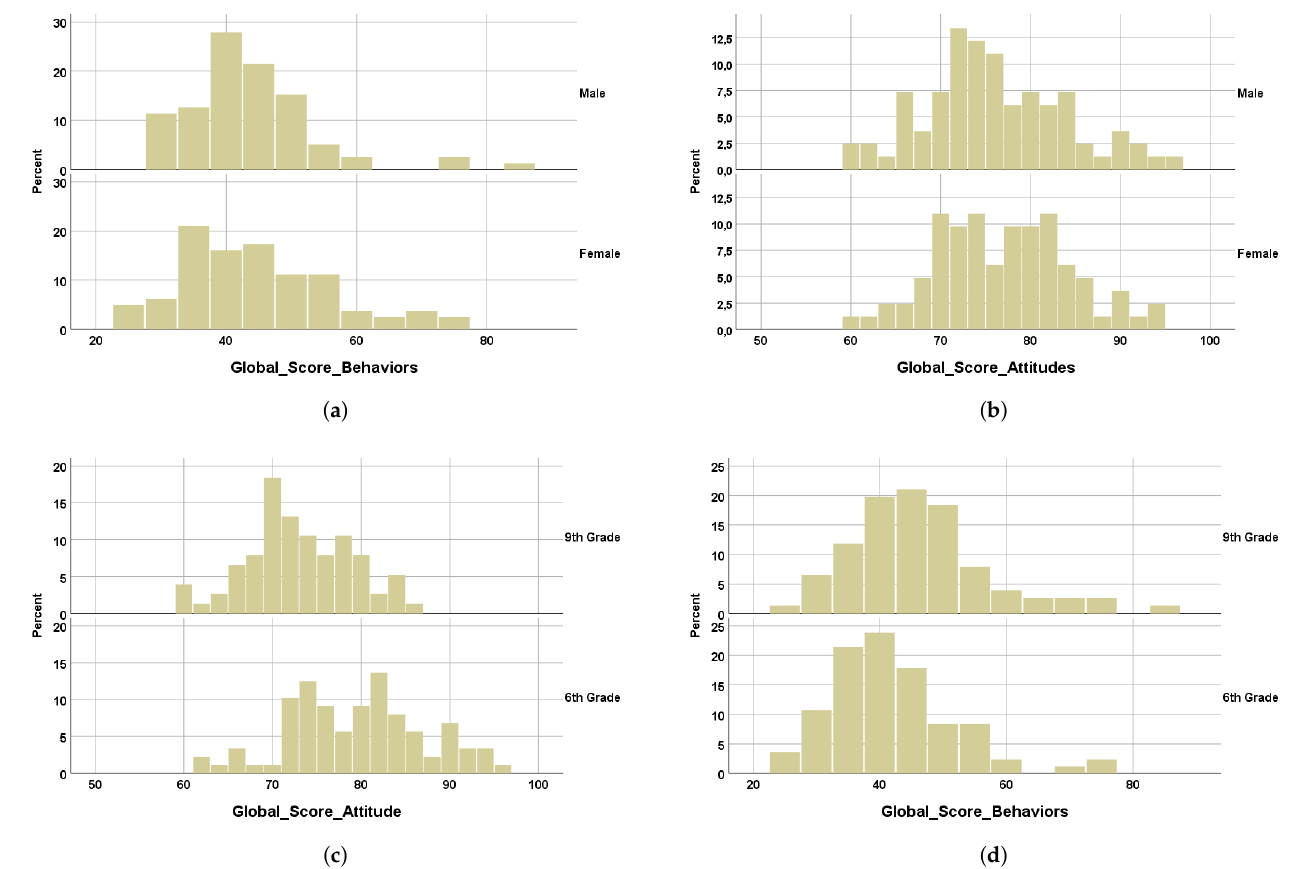
Figure 9. Distribution of global behaviors and attitudes. ( a ) Distribution of global score of behaviors by gender. ( b ) Distribution of global score of attitudes by gender. ( c ) Distribution of global score of attitudes by grade. ( d ) Distribution of global score of behaviors by